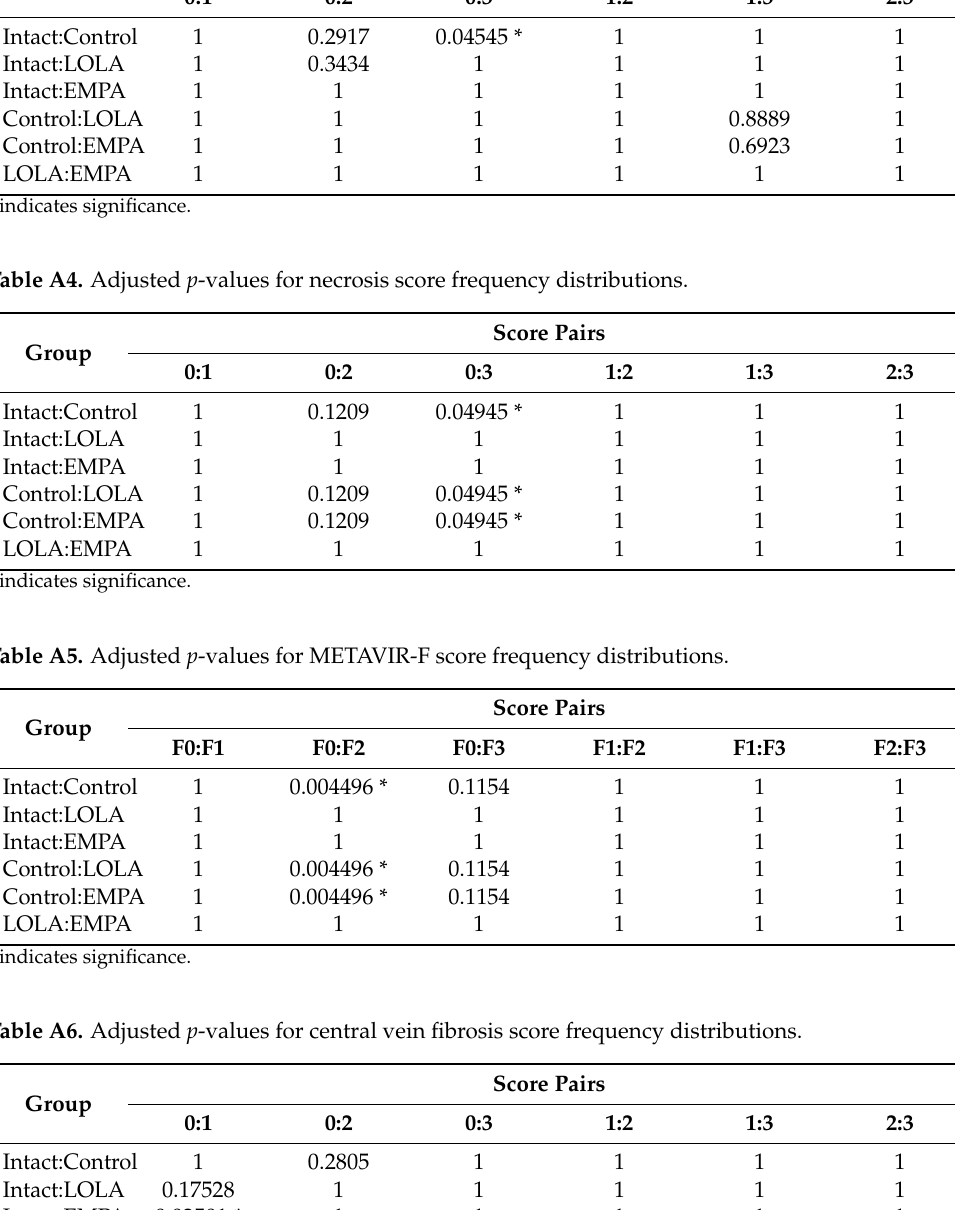
Table A3. Adjusted p -values for hepatocellular ballooning score frequency distributions. Group